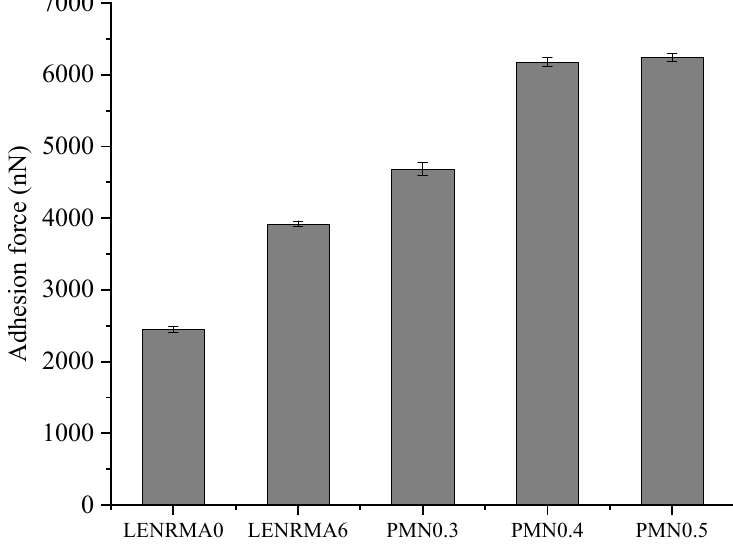
Figure 9. Adhesion by AFM force for all